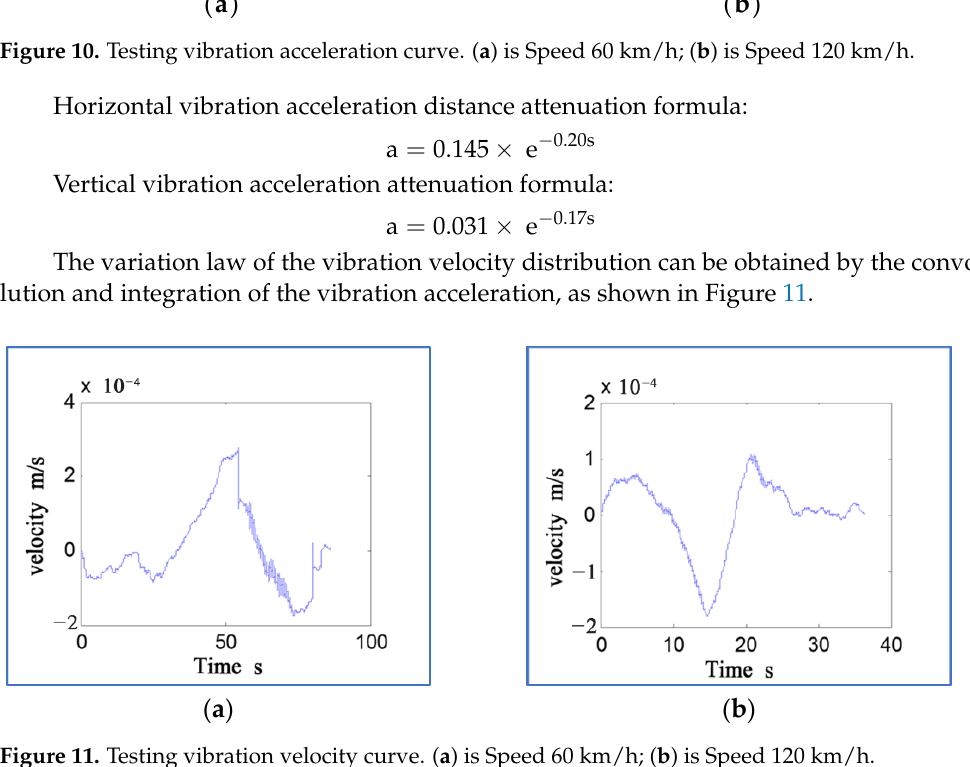
Figure 11. Testing vibration velocity curve. ( a ) is Speed 60 km/h; ( b ) is Speed 120 km/h. Table 3. Blasting vibration